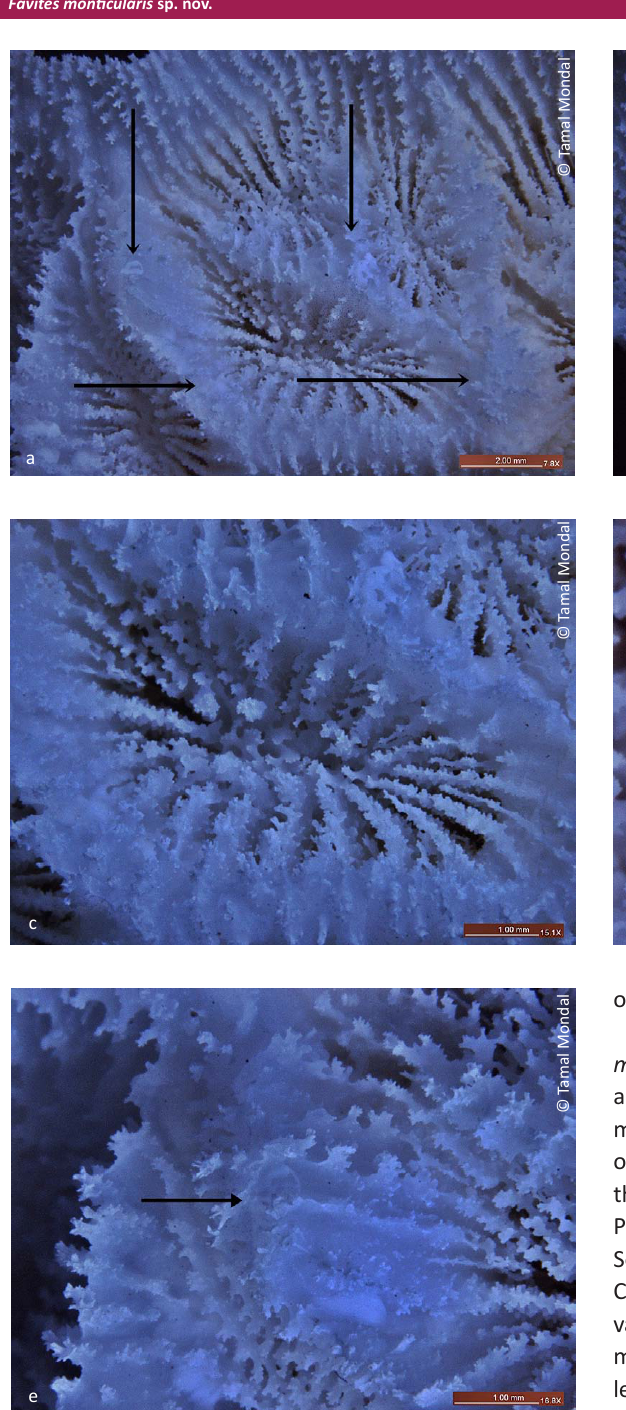
Image 2. Different key characters of Favites monticularis sp. nov. a - Corallites (inner portion); b - Corallites (terminal portion); c - Septal arrangement with dentition; d - Paliform lobes and coenosteum; e - Monticules shaped